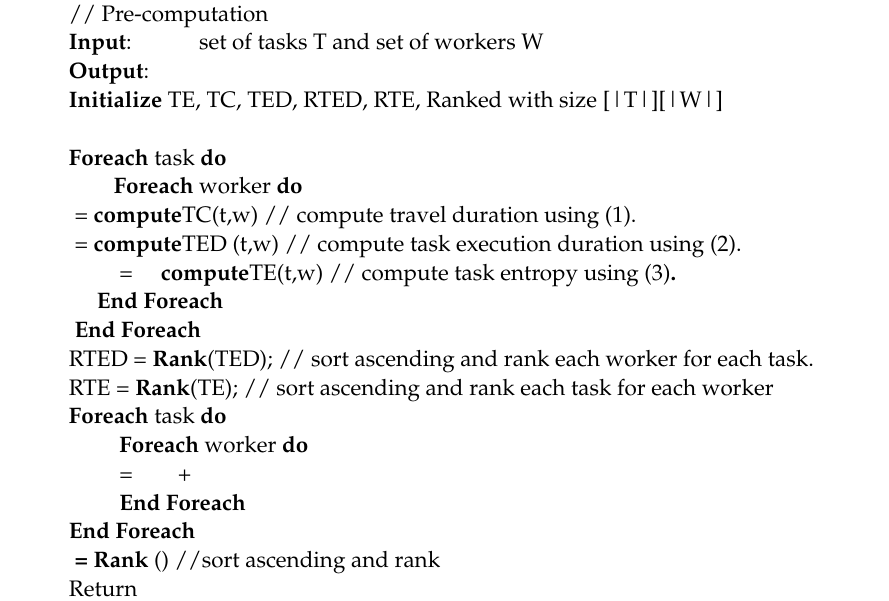
Algorithm 1. Pseudo code for algorithm pre-computation.